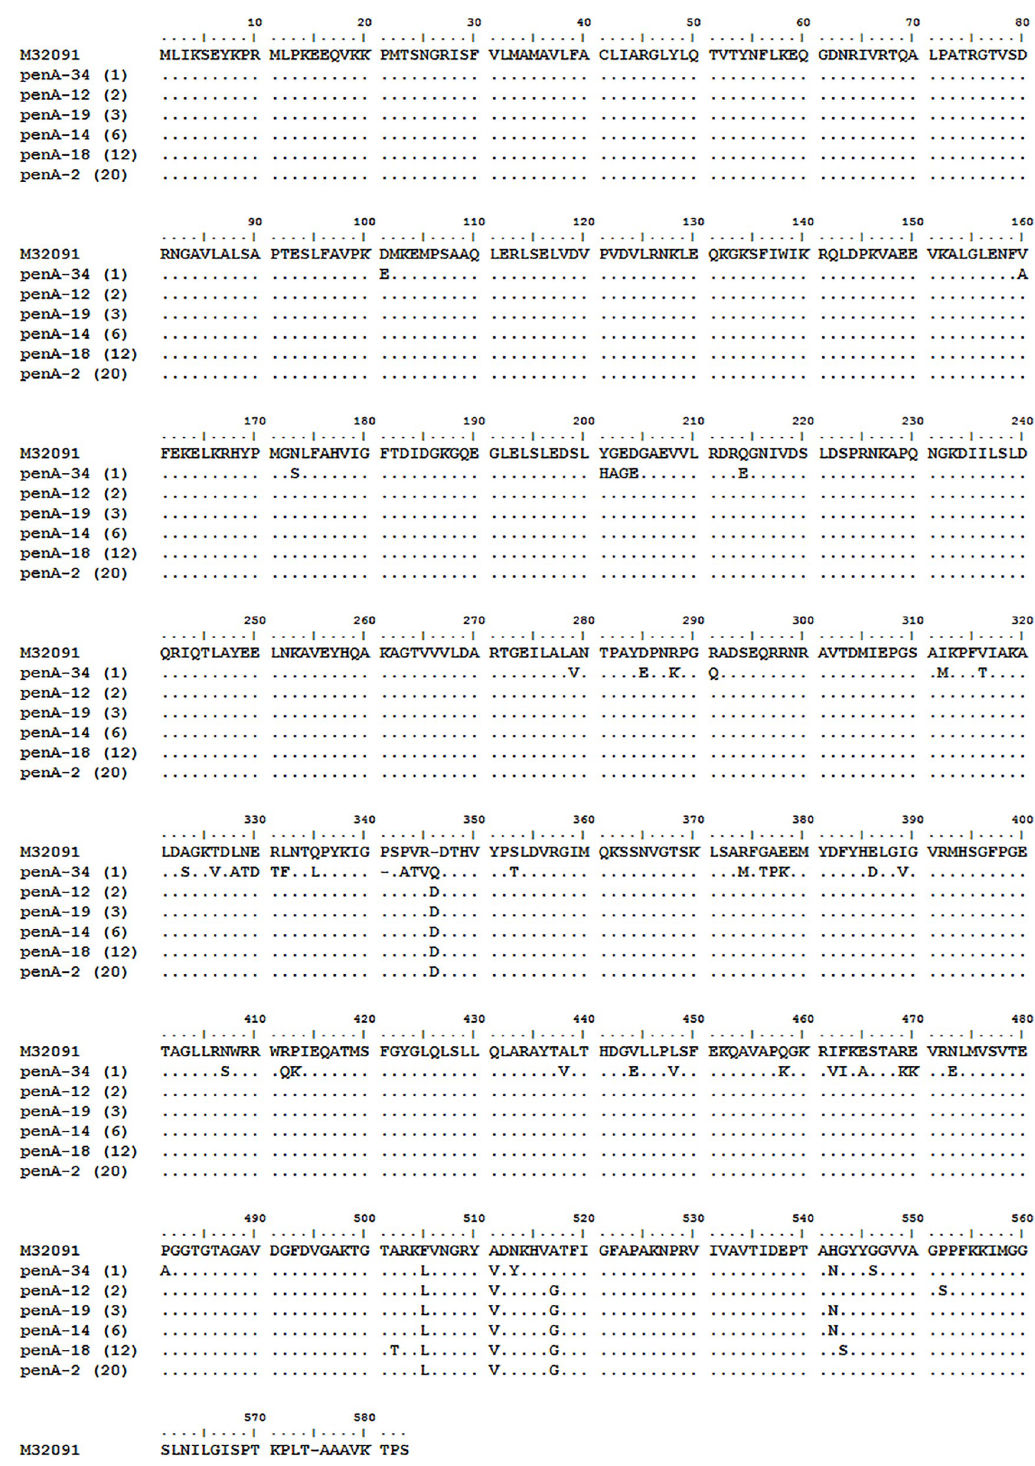
Fig 2. Aligned penicillin binding protein 2 amino acid fragments from 44 N . gonorrhoeae isolates. Here, the sequences are aligned with a reference sequence (GenBank accession number M32091). Showing in parenthesis is the total number of each pattern that was identified. The dots represent identity with the reference allele, while the dashes represent insertions or deletions.